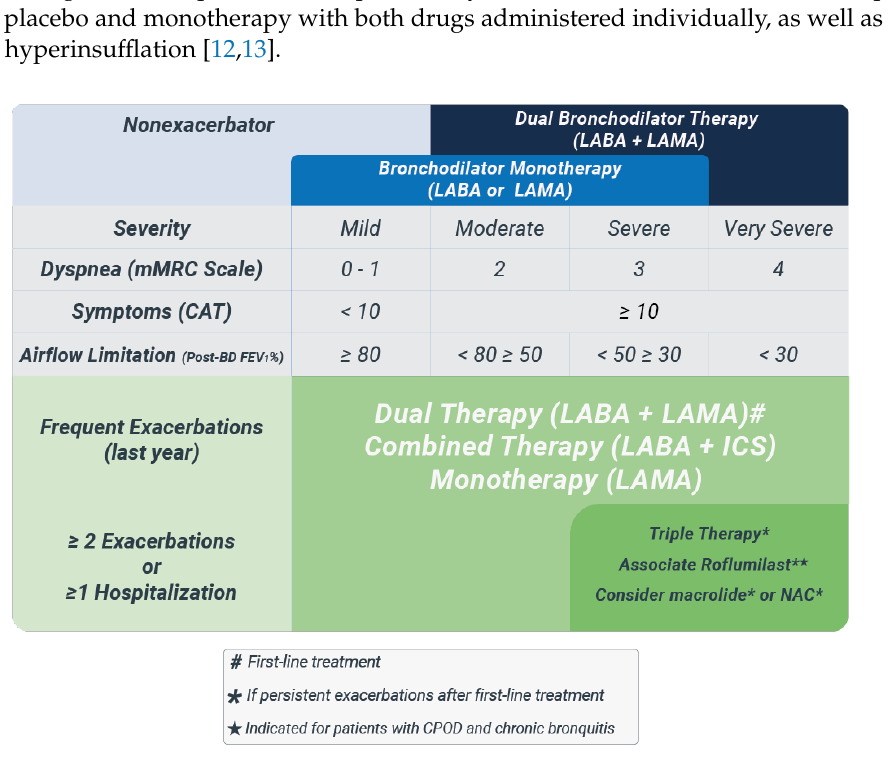
Figure 1. Bronchodilator therapy with potential benefits for COPD patients—blue zone: patients without frequent exacerbations; green zone: frequent exacerbation phenotype. LABA: long-acting β2 -agonist; LAMA: long-acting antimuscarinic; mMRC: modified Medical Research Council dyspnea scale; CAT: COPD assessment test; FEV1%: forced expiratory volume predicted; BD: bronchodilator; ICS: inhaled corticosteroids; NAC: N-acetylcysteine; # First-line treatment; * If persistent Adapted from Fernandes FLA et al., 2017